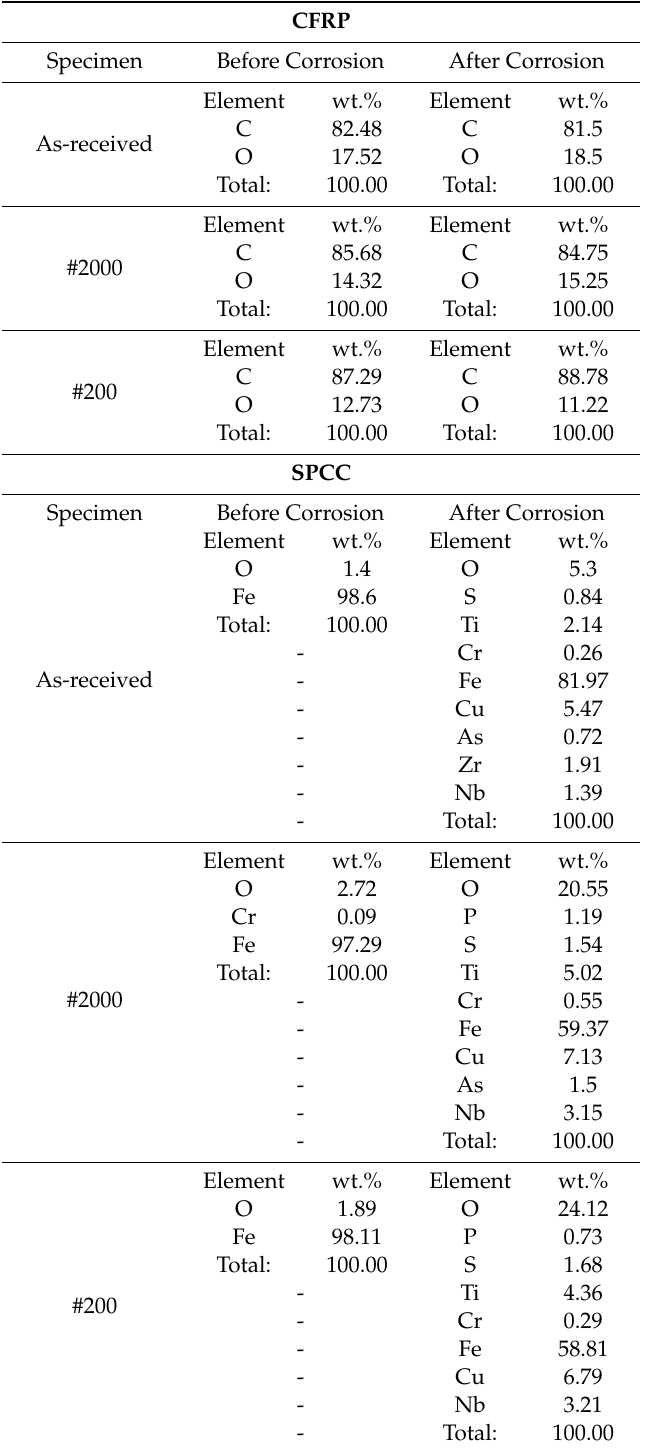
Table 3. Surface composition of CFRP and SPCC, before and after corrosion testing.